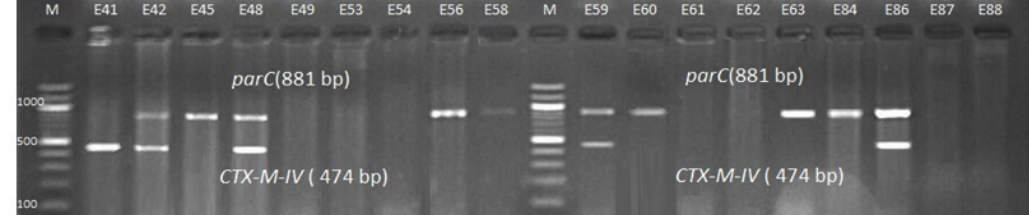
Fig. 7. 1.5% Agarose gel electrophoresis at 72 volt for 90 minutes of PCR to blaCTX-M-IV amplicon (474bp) lane M represent DNA marker size(100bp) while E41-E88 represent the isolates